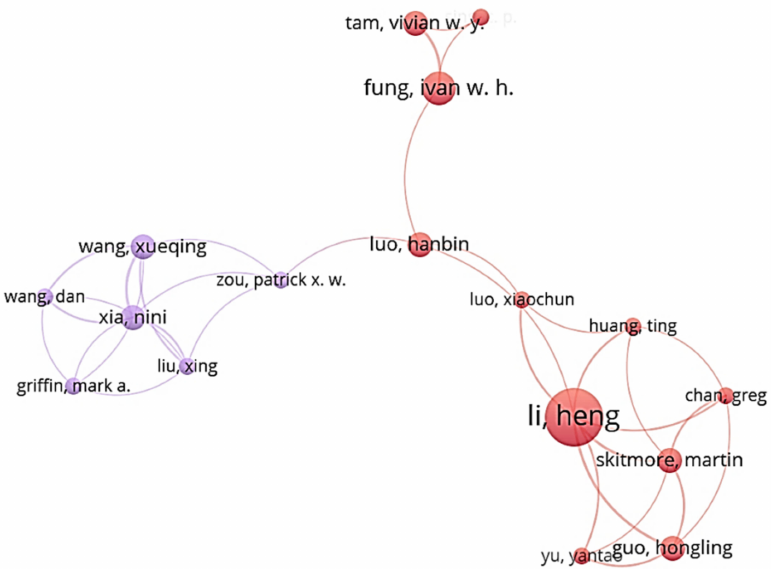
Figure 1. Co-authorship networks of clusters 1 and 5.